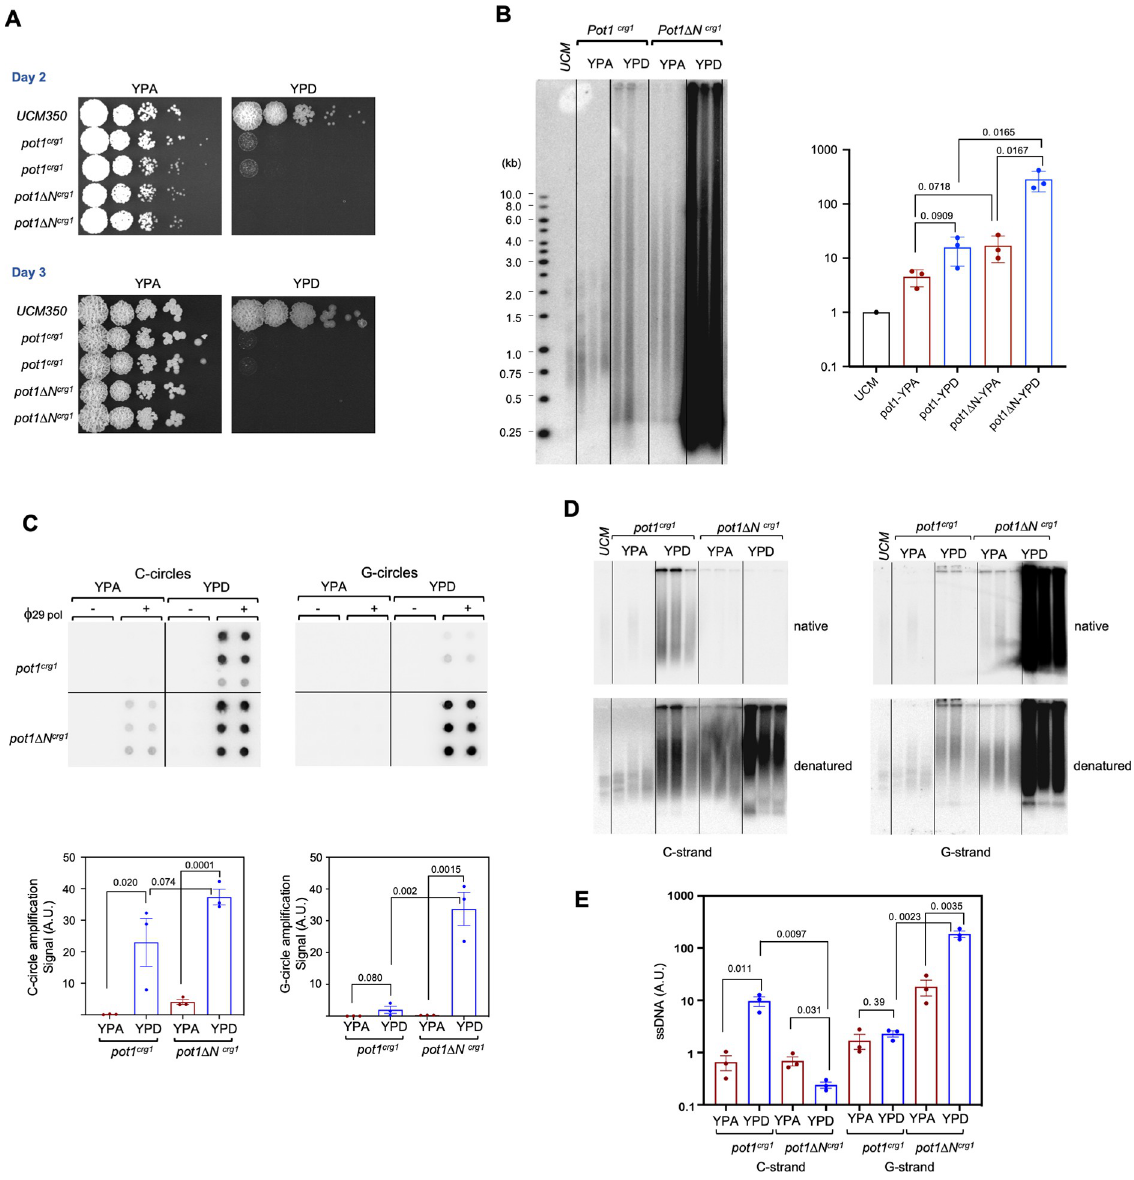
Fig 4. pot1 deficiency triggers growth arrest and multiple telomere aberrations. A. Serial dilutions of the indicated strains were grown on YPA ( crg1 promoter on) and YPD ( crg1 promoter off) plates for 2 and 3 days, and the results photographed. B. Chromosomal DNAs from three independently generated pot1 crg1 and pot1 Δ N crg1 strains grown in YPA and YPD were subjected to telomere restriction fragment analysis. The overall telomere contents of the samples were quantified and plotted on the right. P-values were calculated using two-tailed Student’s t tests. C. Chromosomal DNAs from three independently generated pot1 crg1 and pot1 Δ N crg1 strains grown in YPA and YPD were subjected to C-circle and G-circle assays. The relative levels of C- and G-circles from the three mutants were quantified and plotted at the bottom. P-values were calculated using two-tailed Student’s t tests. D. Chromosomal DNAs from three independently generated pot1 crg1 and pot1 Δ N crg1 strains grown in YPA and YPD were subjected to in-gel hybridization analysis of ssDNA on both the G- and the C-strand. E. The levels of ssDNA from the in-gel hybridization assays were quantified (N = 3) and plotted. P-values were calculated using two-tailed Student’s t